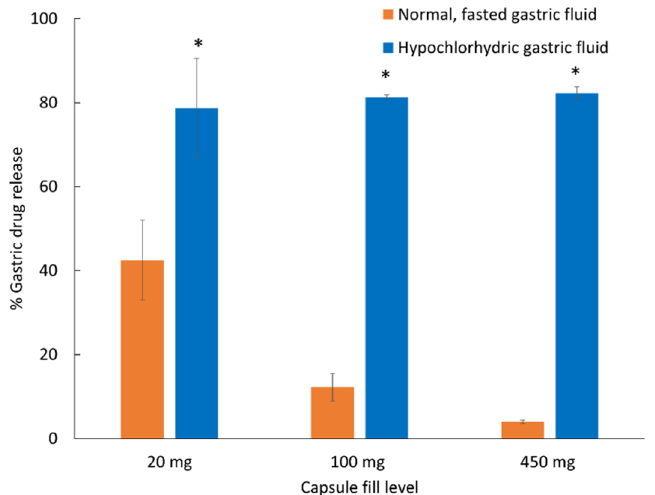
Figure 6. Trimethoprim release from Vcaps Enteric capsules with different fill levels after two-hour exposure to normal, fasted or hypochlorhydric, simulated gastric fluids. * Indicates significantly higher ( p < 0.05) premature gastric release under hypochlorhydic, simulated fluids compared to normal, fasted simulated gastric fluids. Data shown as drug release mean % ± SD.